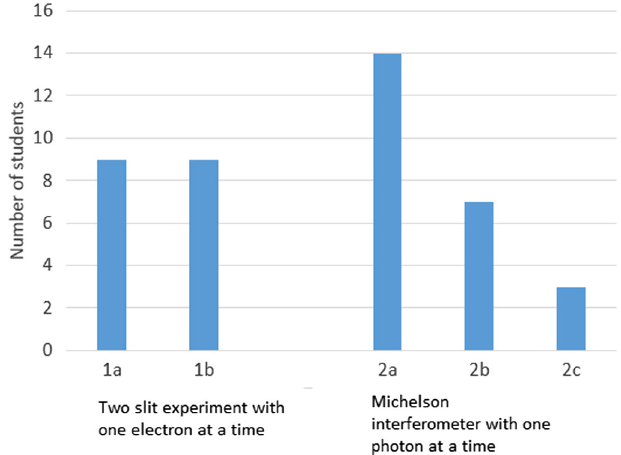
FIG. 5. Results (number of answers judged as basically correct) for each item in the final assessment test ( N ¼ 17